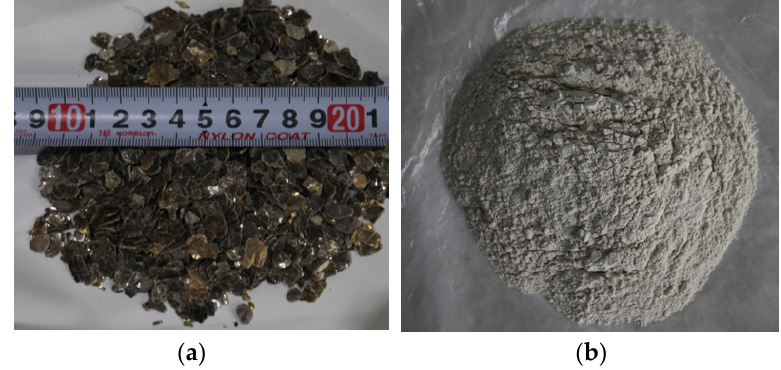
Figure 1. Photos of the expansion-induced materials: ( a ) vermiculite flake; ( b ) MgO powder.